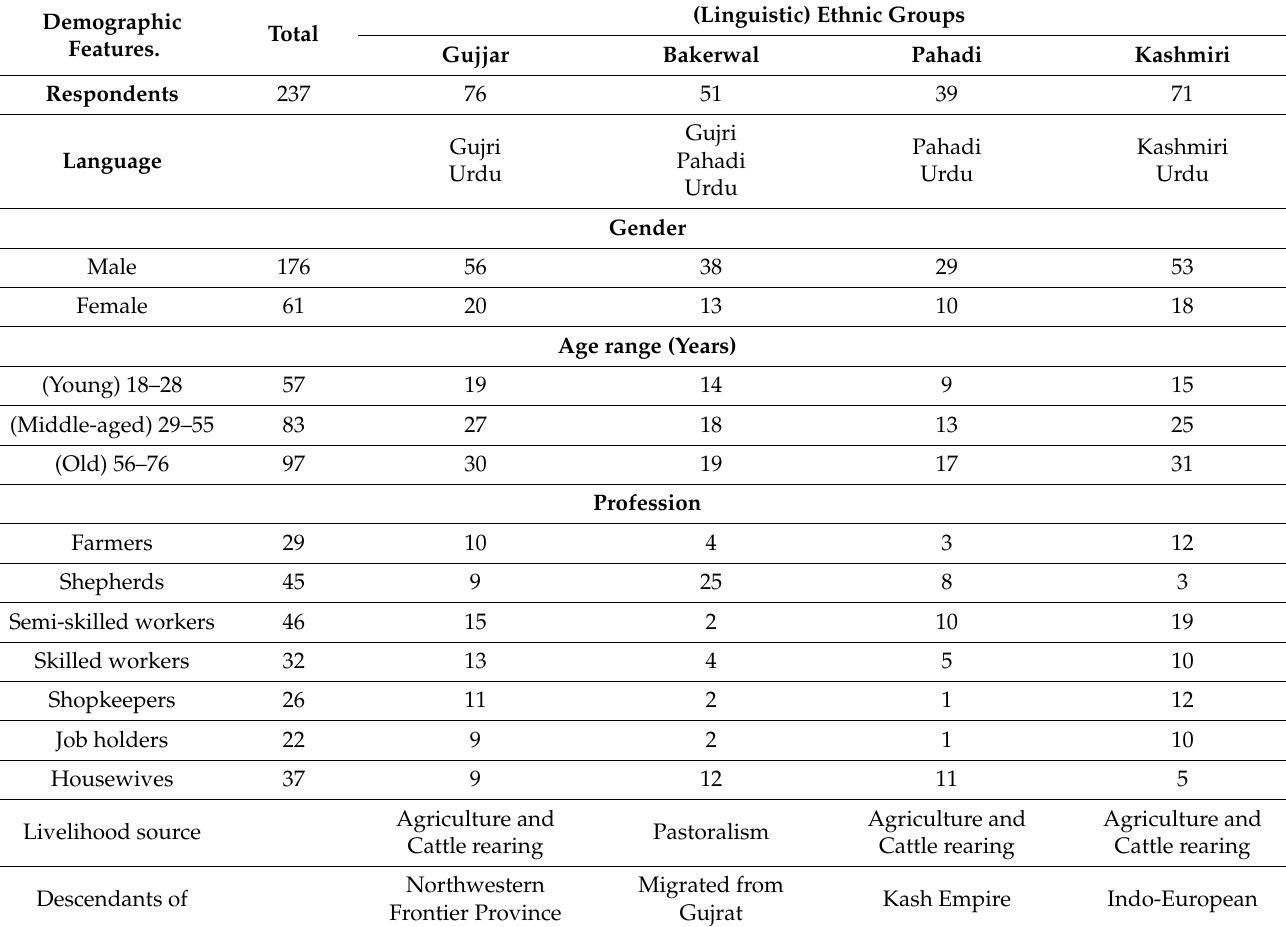
Table 1. Demographic status of respondents from North Kashmir